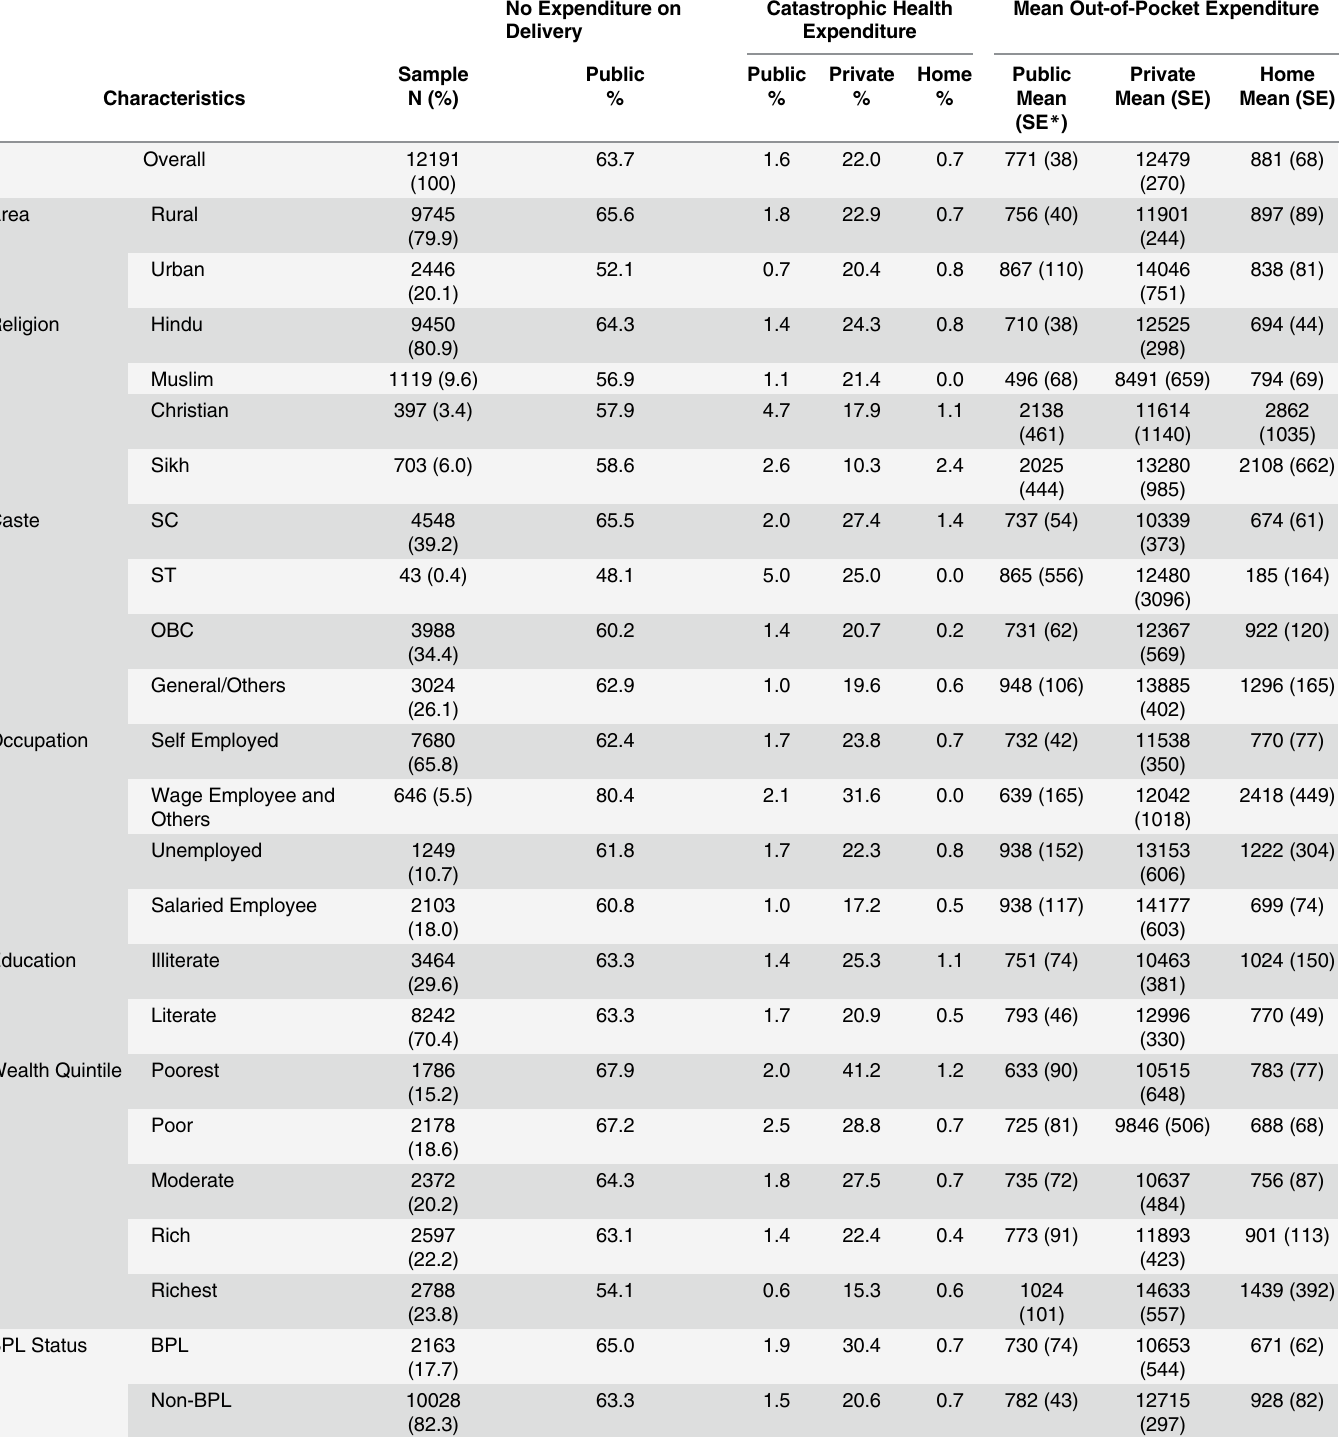
Table 1. Socio-Demographic Profile, Delivery Characteristics and Delivery